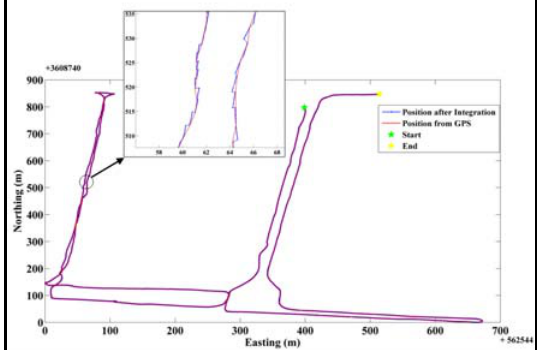
Figure 7. Test path before and after integration via EKF A few examples of traffic signs recognized in this road are depicted in Table 1. For each sign, its true 3D position is also measured manually by static DGPS. The results are compared with the coordinates derived from our system. The last columns show the absolute difference of the manually measured and automatically computed coordinates. The average values of the differences for all the test dataset are 0.110, 0.131 and 0.120 meters in three Cartesian directions of WGS84 reference system. The RMS error of positioning in X,Y and Z directions are 0.116, 0.136 and 0.125 meters respectively. As a result, 90% true positive recognition is achieved. Referring to Table 1, samples 6 and 8 are correctly detected even with partial occlusion; signs 1, 3, 4 are validly recognized even in spite of the disorientation and scaling problems; signs 3, 4, 5, 7 are also correctly recognized despite the illumination variations. All the programs are implemented by MATLAB programming on an Intel Core2 Duo CPU 2.2 GHz / 789 MHz. The detection process takes averagely 0.0285 seconds; the detection and recognition processes totally consume 0.4063 seconds; and extracting the 3D coordinate of an image point needs only 0.0002 seconds.